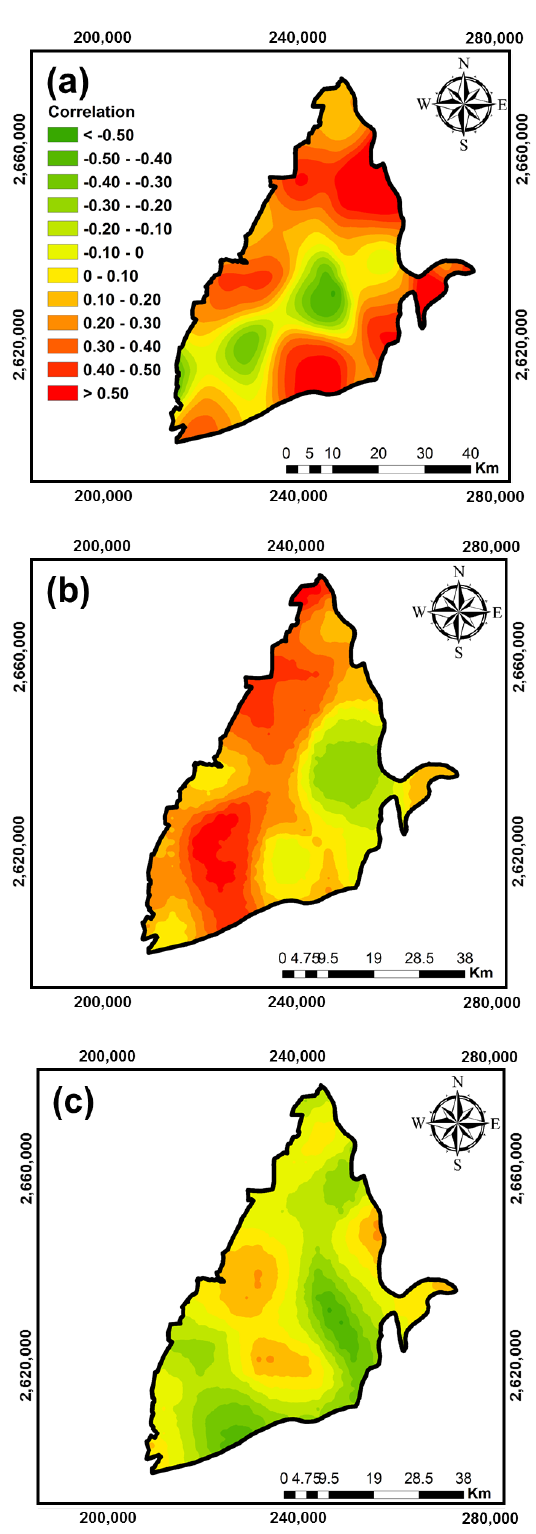
Figure 9. The distributions of Pearson Correlation for GWL and GWR: ( a ) the annual average correlation, ( b ) the wet months (May–October), and ( c ) the dry months (November–April).